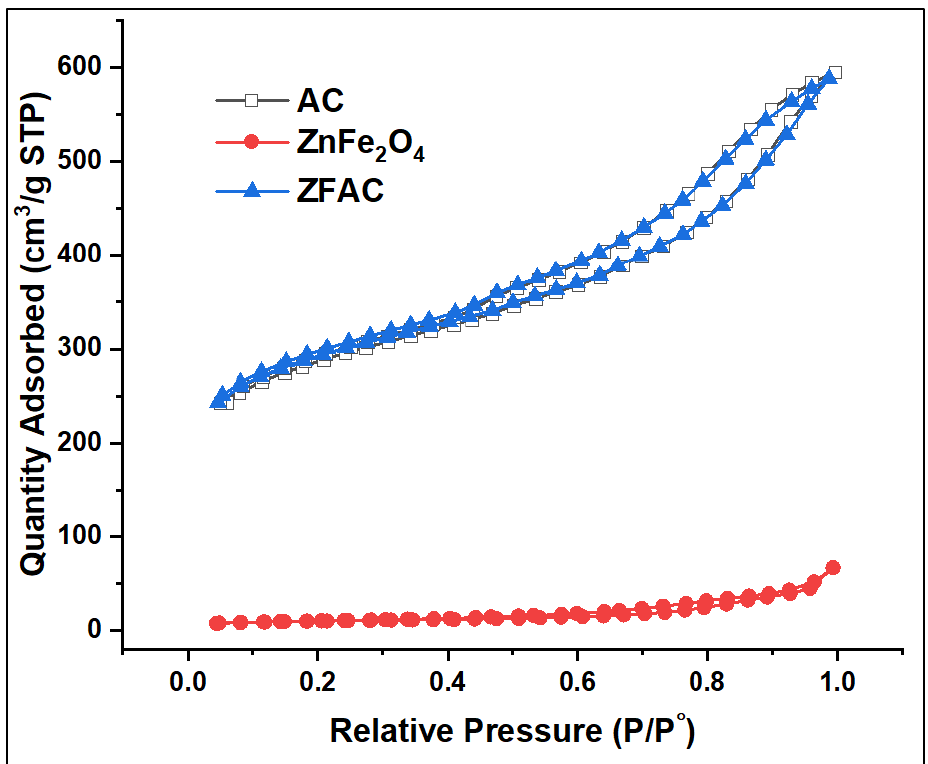
Figure 4. Nitrogen adsorption–desorption isotherms of activated carbon (AC), ZnFe 2 O 4 , and ZnFe 2 O 4 –AC (ZFAC).